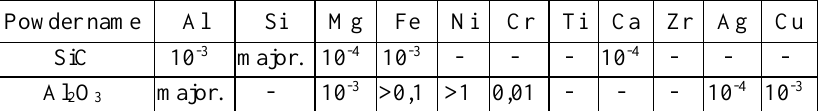
Results of analysis of initial powders in masses.